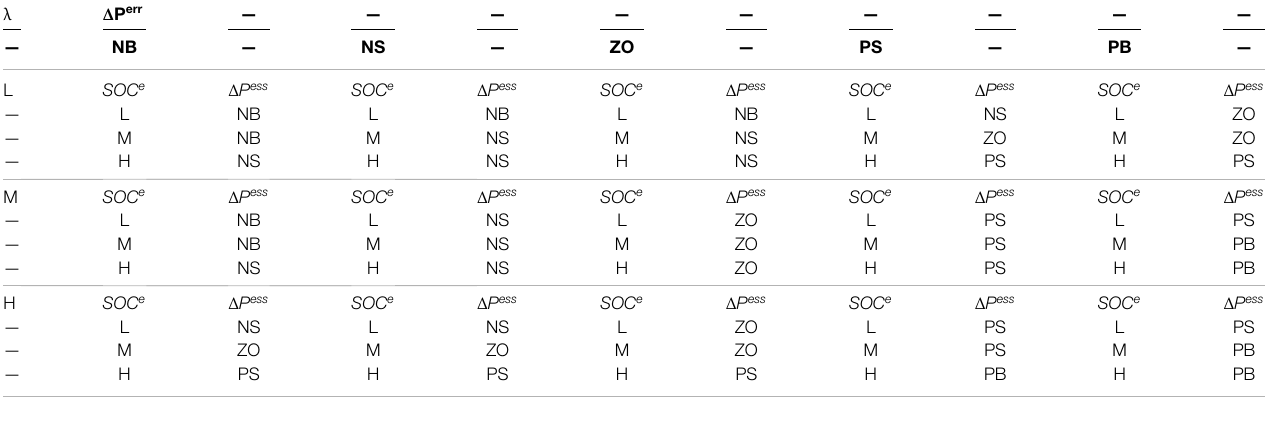
TABLE 3 | Rules of ESS system operations. ( U ess )